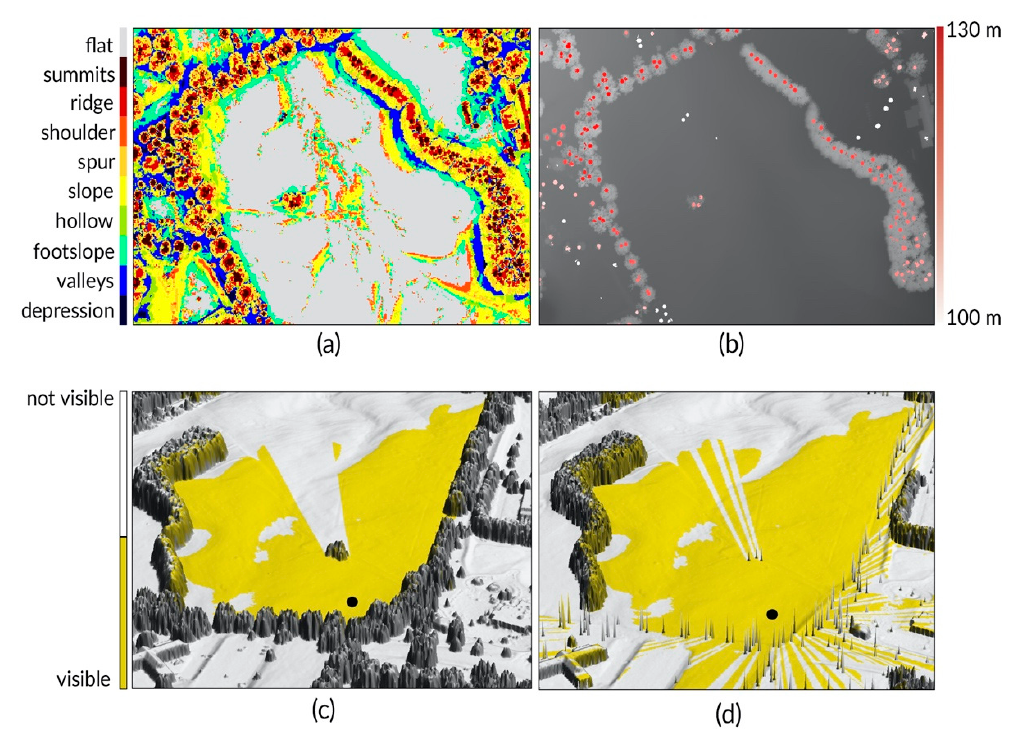
Figure 9. Trunk obstruction modeling results: ( a ) Geomorphon landform detection results, where the summits are shown in brown; ( b ) the extracted peaks with elevation values; the modeled viewscape before ( c ) and after ( d ) trunk modeling (black dot represents the viewpoint).